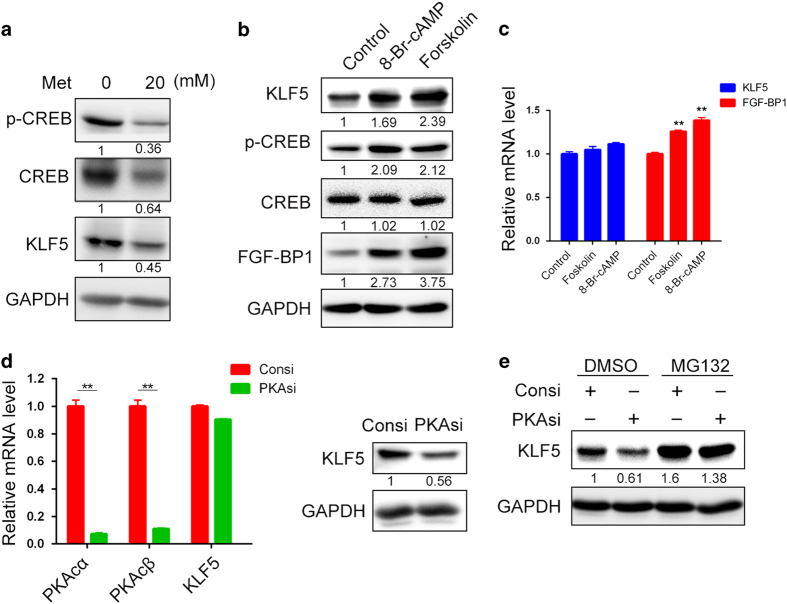
Metformin decreases the KLF5 expression through the inhibition of PKA. (a) Metformin inhibited the activity of PKA. HCC1937 cells were treated with metformin (20 mM) for 24 h. The p-CREB and KLF5 levels were then measured by WB. (b) Two activators of PKA, 8-Br-cAMP (1 mM) and forskolin (10 μm), increased the p-CREB and KLF5 protein levels, respectively. HCC1937 cells were treated with these PKA activators for 24 h. KLF5, p-CREB, CREB and FGF-BP1 were examined by WB. (c) Two activators of PKA, 8-Br-cAMP (1 mM) and forskolin (10 μm), did not cause an increase in the mRNA levels of KLF5 in HCC1937 cells. However, the FGF-BP1 mRNA level was significantly upregulated, as measured by quantitative RT-PCR. The statistical significance was determined by Student’s t-test. **P<0.01. (d) PKA knockdown decreased the KLF5 protein level in HCC1937 cells. PKAc was knocked down using two different siRNAs that each targeted the PKAcα and PKAcβ isoforms. HCC1937 cells were transfected with the siRNAs for 72 h, and the cell lysates were collected for qRT-PCR and WB. The statistical significance was determined by Student’s t-test. **P<0.01. (e) MG132 blocked the decrease in KLF5 induced by PKA knockdown in HCC1937 cells. The cells were transfected with PKA siRNAs for 72 h and were then treated with MG132 (20 μm) for 12 h.